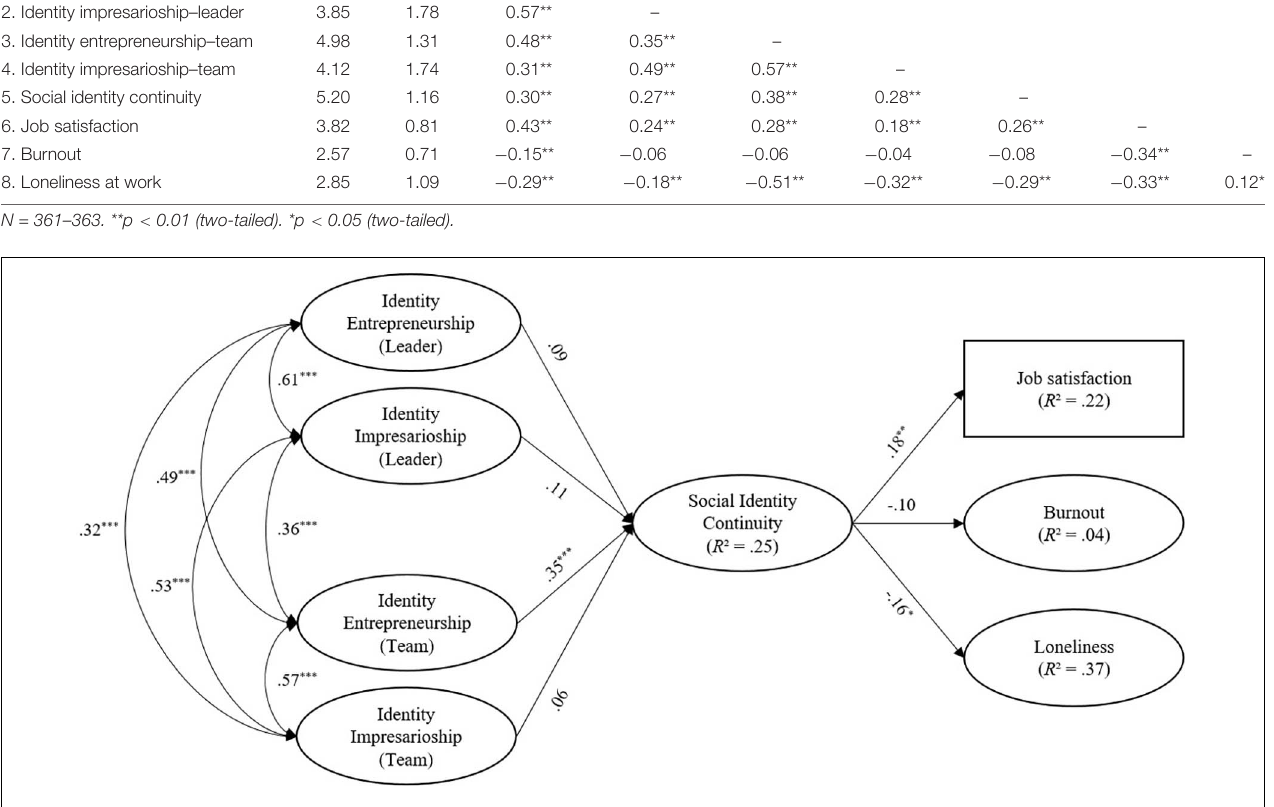
FIGURE 1 | Standardized effects and correlations from the structural equation model. N = 361. * p < 0.05, ** p < 0.01, *** p < 0.001. Direct effects of IVs are not displayed for the sake of clarity. See Table 3 for direct